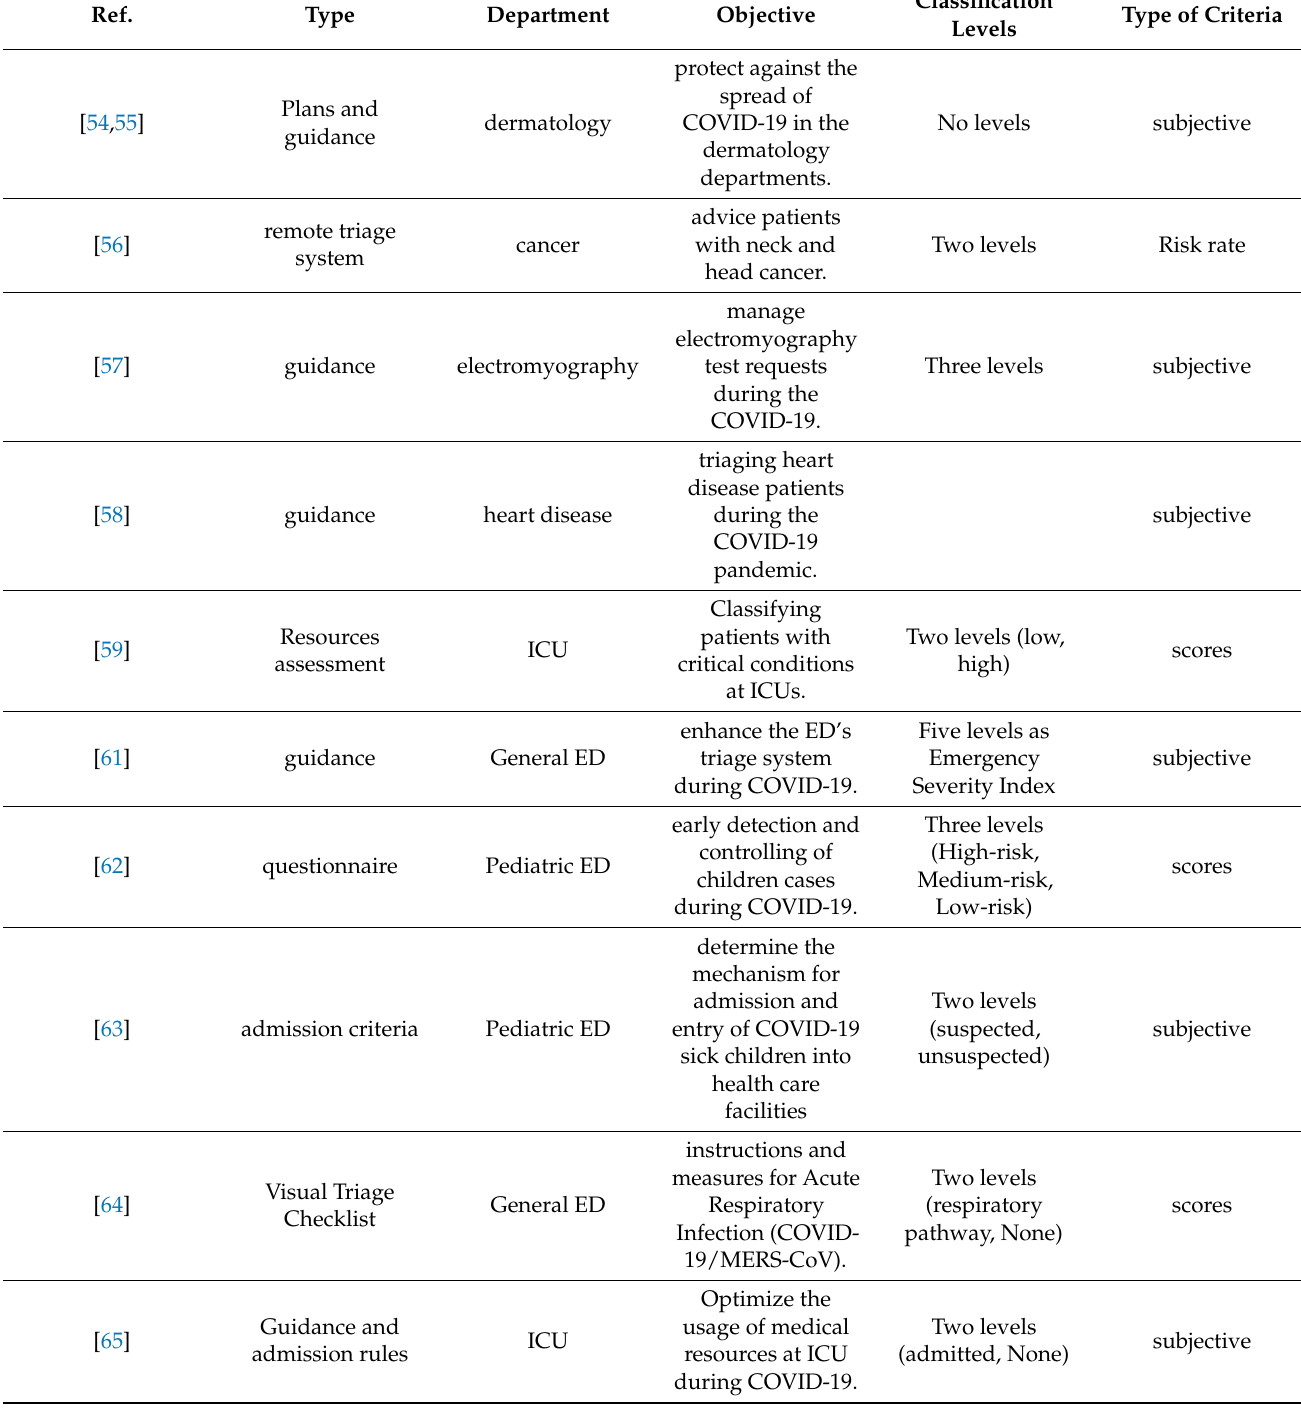
Table 8. Proposed studies on COVID-19 triage